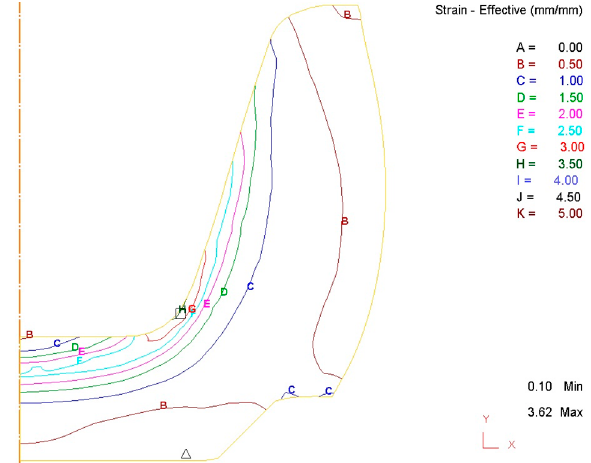
Figure 12. Strain contours obtained in finite element simulation at the end of stroke (11 mm) obtained at temperature and speed of 420 °C/0.01 mm · s − 1 (Domain 1).